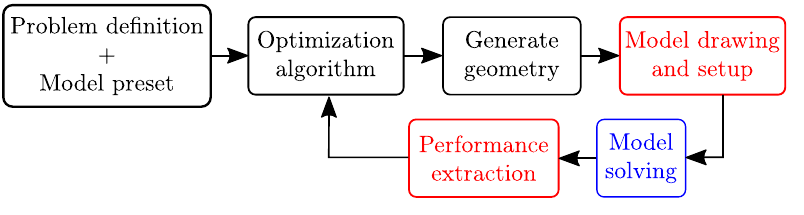
Figure 5. Optimization